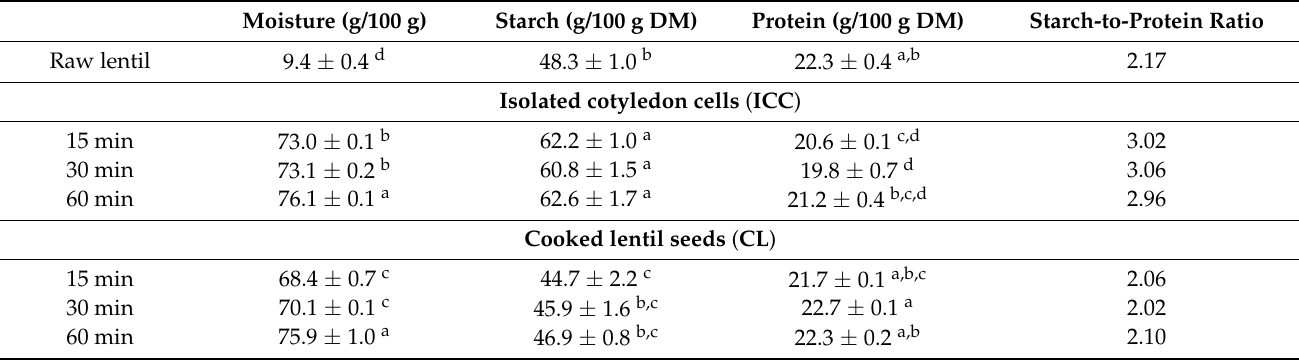
Table 1. Macronutrient composition (in g/100 g dry matter) of whole cooked lentil seeds and cotyledon cells isolated thereof as a function of the applied cooking time. Reported values are means of duplicate measurements ± standard deviation. Within a column, different superscript letters indicate significant differences between the reported means ( p <